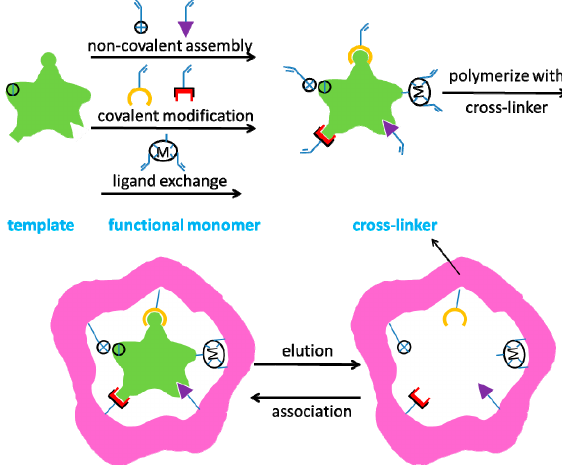
Figure 1. Schematic diagram of molecular imprinting process.